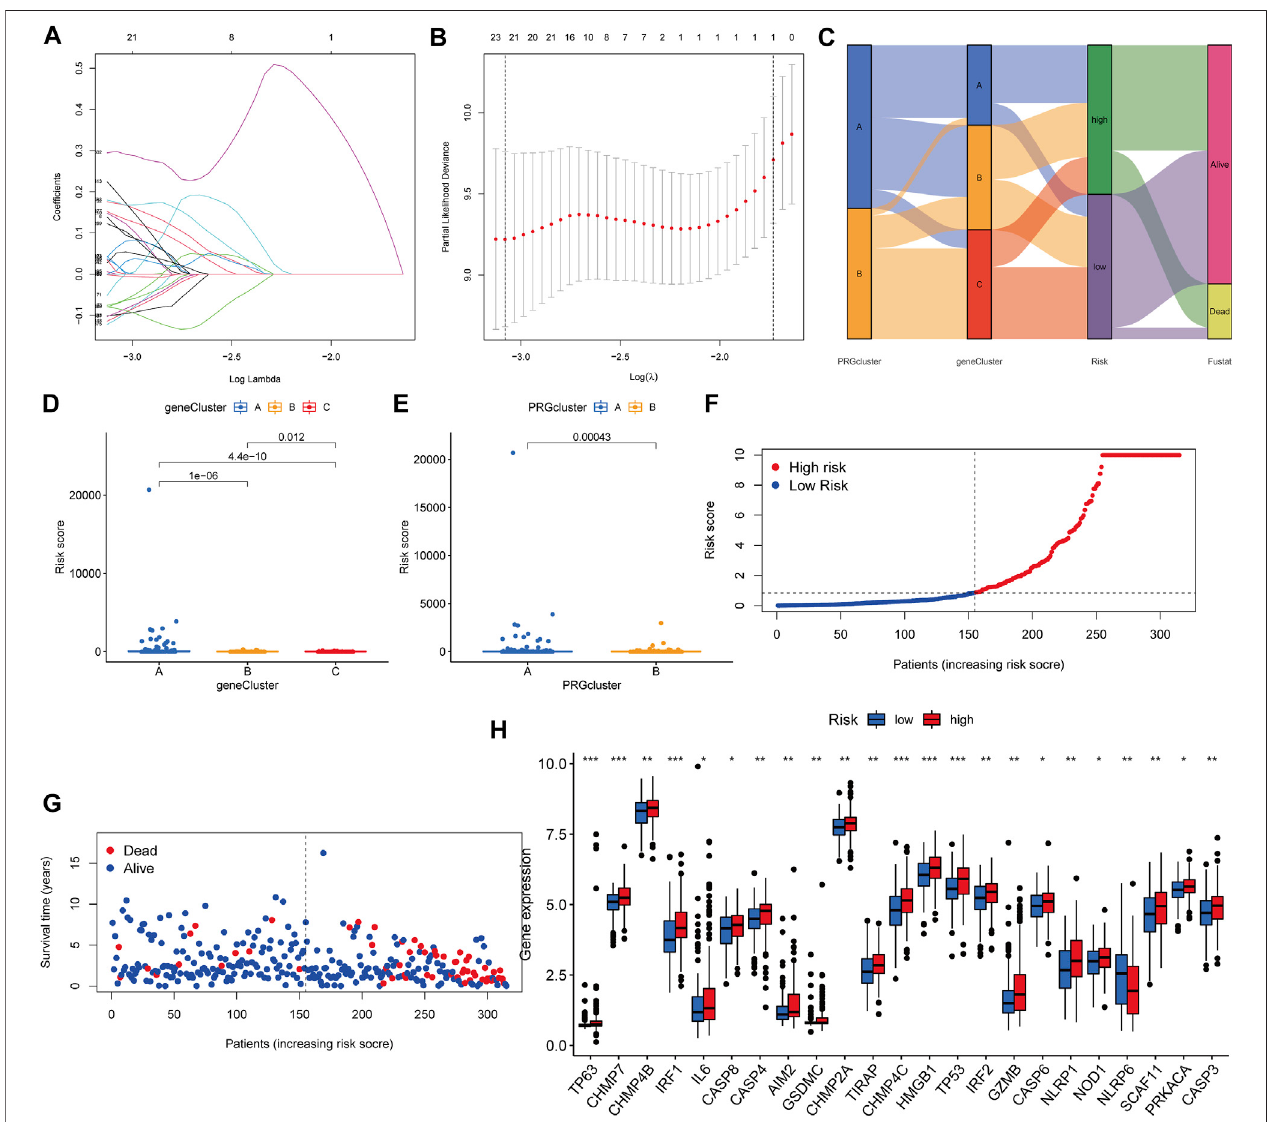
FIGURE6| Generation ofthe PRGsignaturescoring system. (A – B) LASSOregressionanalysis andpartial likelihood devianceon prognostic genes. (C) Analluvial plot illustrating the link between the pyroptosis cluster, the gene cluster, and the pyroptosis score. (D) The PRG score in different genecluster subgroups. (E) The distribution of PRG scores in various PRGcluster subgroups. (F – G) The ranked dot plot depicts the distribution of PRG scores, whereas the scatter plot depicts the survival state. (H) Variations in PRG expression across risk categories.